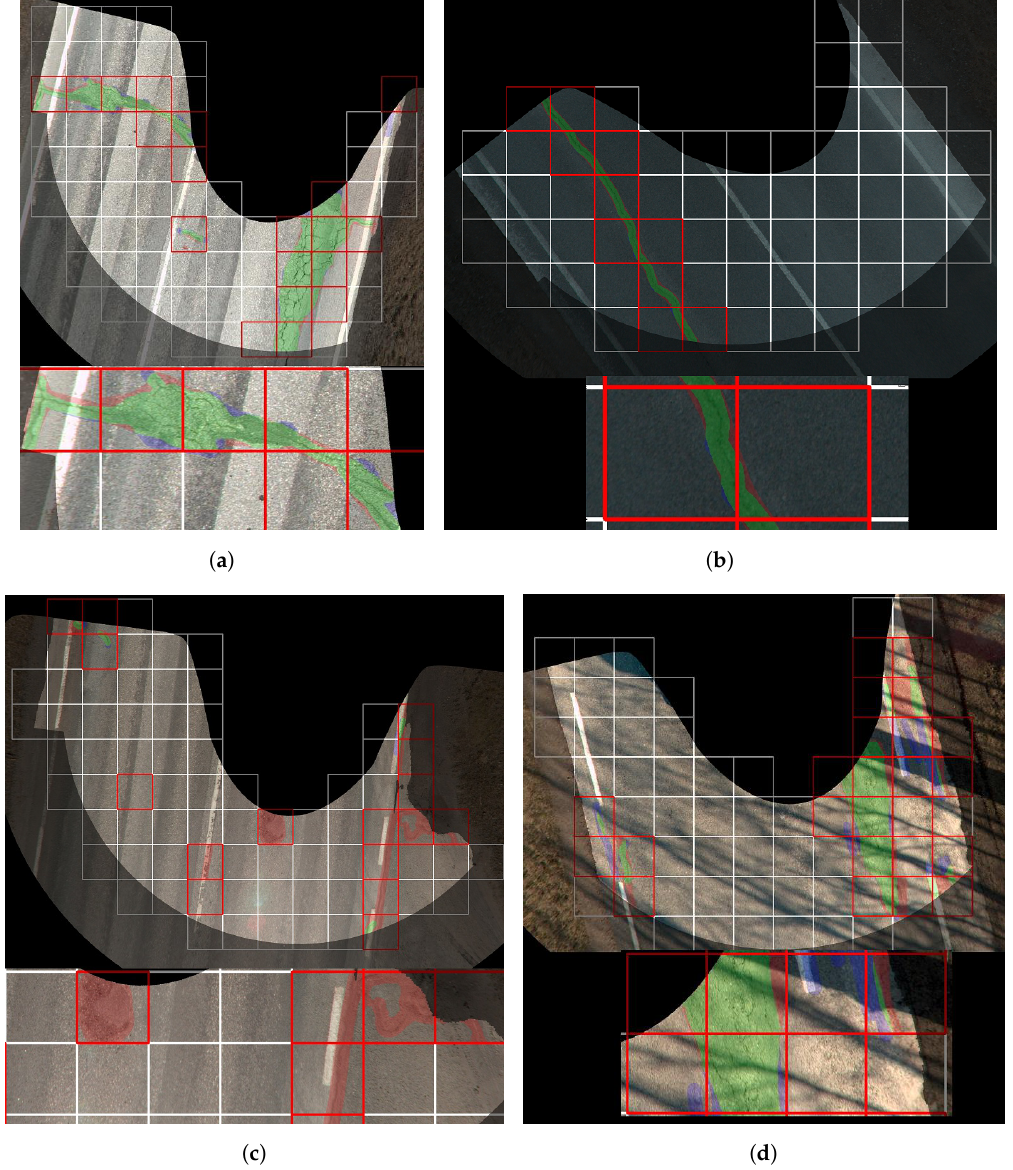
Figure 17. Orthoframes from the test set processed by the PDDS . RSN outputs multiplied by the region of interest mask are highlighted. Patches classified by the DDN as non-defective have white borders and patches classified as defective have red borders. For the masks produced by DSN, the green, red and blue contours represent true positive, false positive and false negative pixels respectively. ( a ) IoU = 0.846, eIoU = 0.930, iIoU = 0.457, cPr = 0.600, cRc = 0.750; ( b ) IoU = 0.790, eIoU = 0.991, iIoU = 0.582, cPr = 1, cRc = 1; ( c ) IoU = 0.104, eIoU = 0.110, iIoU = 0.306, cPr = 0.143, cRc = 1; ( d ) IoU = 0.515, eIoU = 0.575, iIoU = 0.306, cPr = 0.750, cRc =